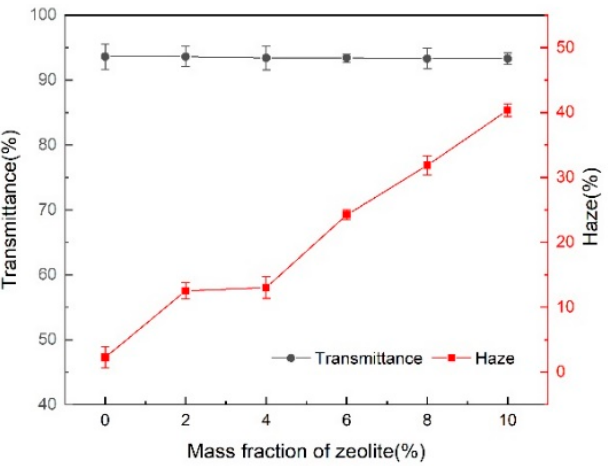
Figure 8. The effect of zeolite on the light transmittance and haze of PLA composites.